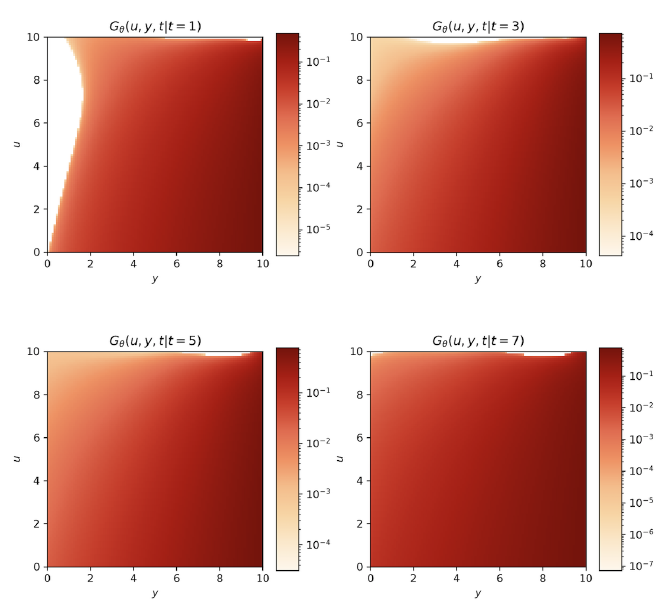
Figure 10. The values of G θ ( u , y , t ) for a fixed t (exponential